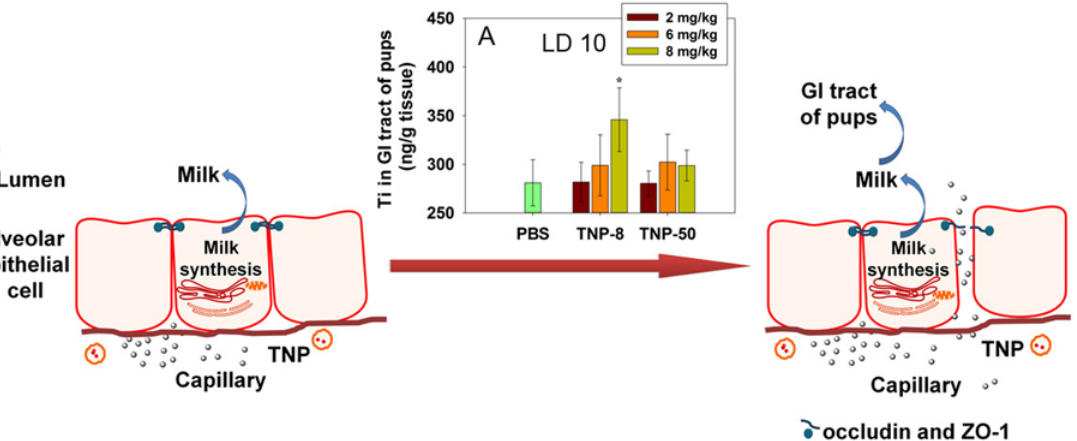
Fig 6. The Ti content in pups ’ GI tract and a cartoon presentation showing that TNPs cross the damaged tight junction entering the milk in lactating dams. (A) Ti content in pups ’ GI tract at LD 10 after four doses of TNP exposures to lactating dams at LD 2, 4, 6 and 8. Symbol * represents significant difference from the PBS group (P < 0.05). GI tract tissues from eight pups were collected per dam and pooled. There are five dams in each group. Data are mean ± s.d. (B) A cartoon presentation showing that TNPs cross the damaged tight junction entering the milk in lactating